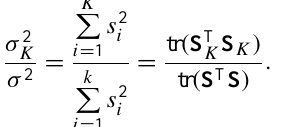
variance of each variable restored in the